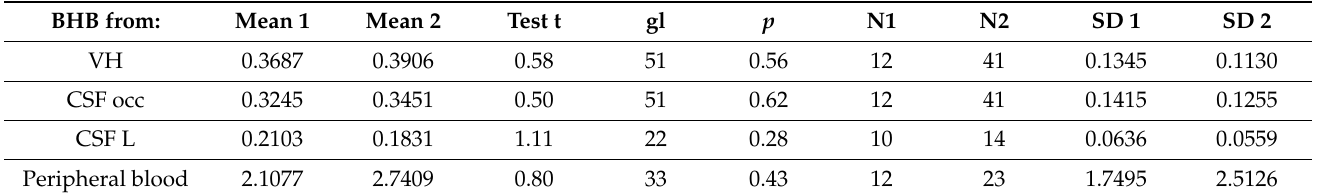
Table 5. BHB according to presence/absence of known DM